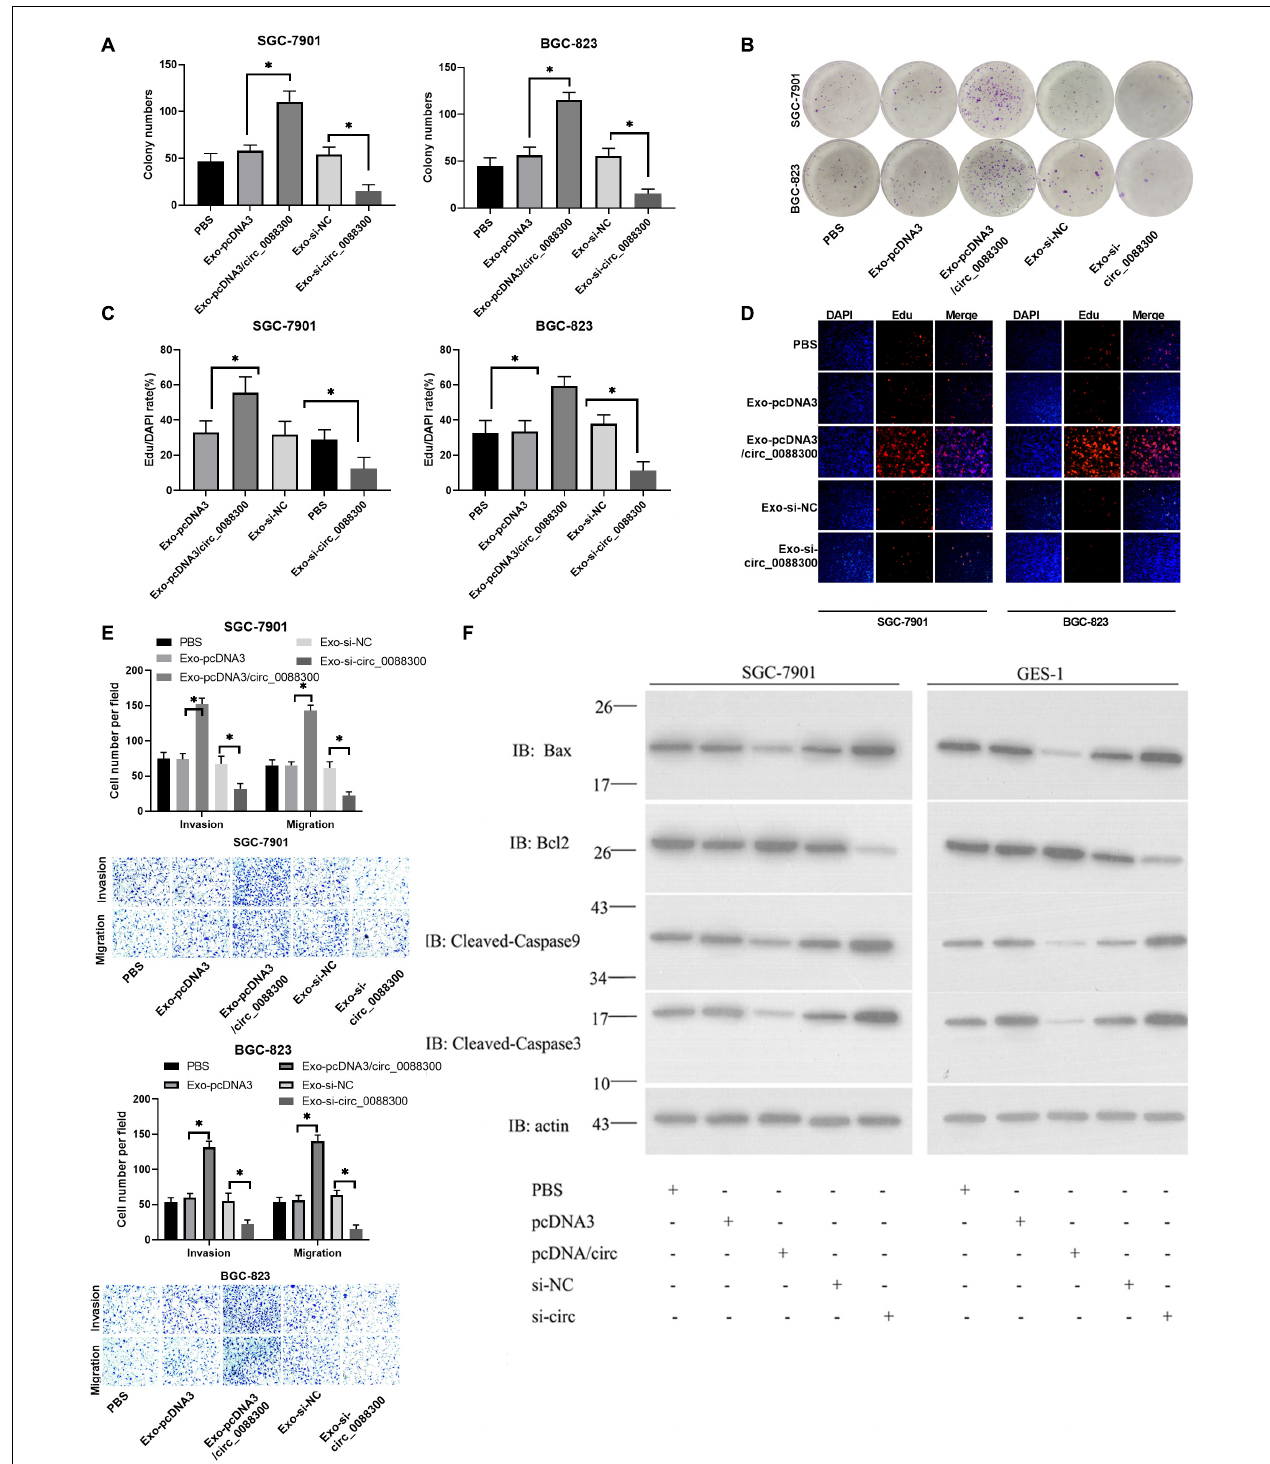
FIGURE 5 | Exosomal transfer of circ_0088300 enhances malignant transformation in vitro . (A,B) Plate colony formation assay of SGC-7901 and BGC-823 cells treated with exosomes derived from CAFs transfected with pcDNA3/circ_0088300 or si-circ_0088300. (C,D) EdU assay of SGC-7901 and BGC-823 cells treated with exosomes derived from CAFs transfected with pcDNA3/circ_0088300 or si-circ_0088300 (scale bar = 50 µ m). (E) Transwell assays of SGC-7901 and BGC-823 cells transfected with pcDNA3/circ_0088300 or si-circ_0088300 were performed to evaluate cell migration and invasion abilities. (F) Western blot assays were used to analyze the protein expression levels of apoptosis and anti-apoptosis proteins in GC cells ( ∗ P < 0.05).